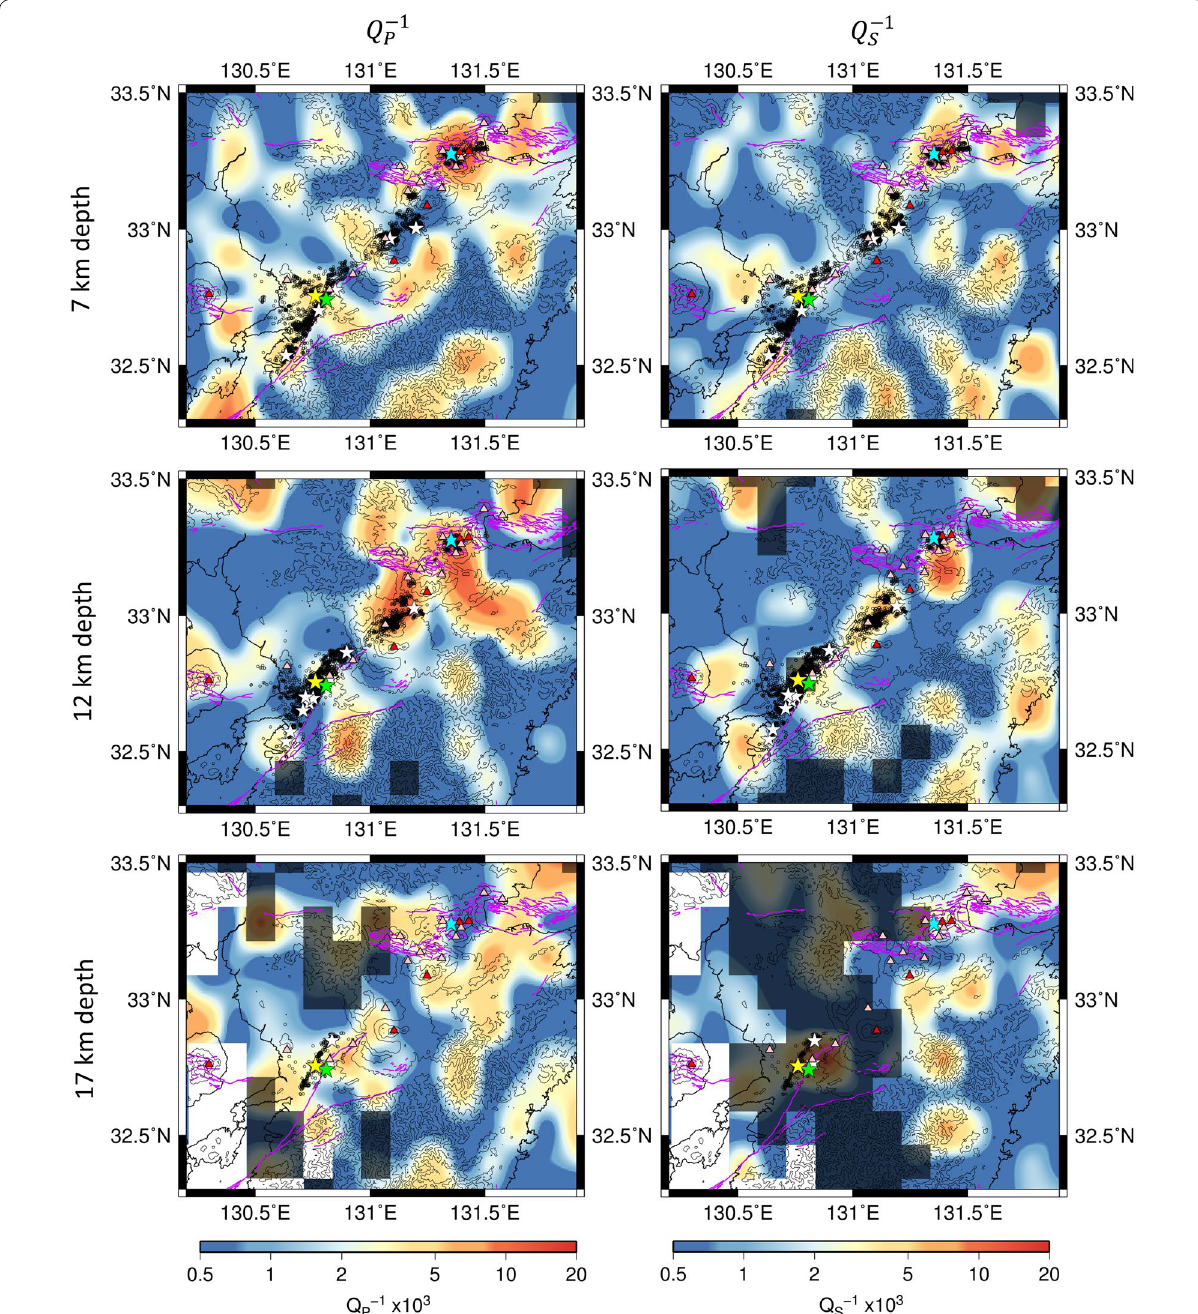
Fig. 2 Lateral distribution of estimated Q − 1 P and Q − 1 S in the crust. The region shaded by gray shows low resolution, where the resolvability R is smaller than 0.75. See the caption of Fig. 1 for explanation of the lines and